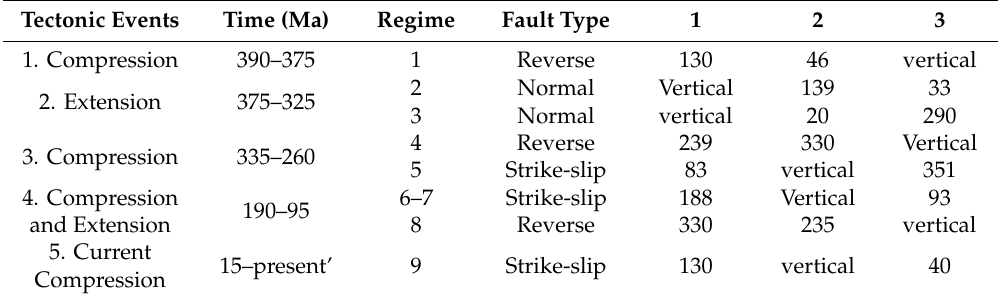
Table 2. Tectonic paleo-stress chronology including: tectonic events (compressional or extensional), relative chronological order, regime number, fault type, and orientation of the three principal stresses, as determined by fault-slip analysis in the present study. The time ranges are from the published literature where known tectonic events in the region have been dated as presented in Section 2 above. The orientation of the principal stresses for each tectonic event has one oriented vertical and two horizontal with azimuthal angles as